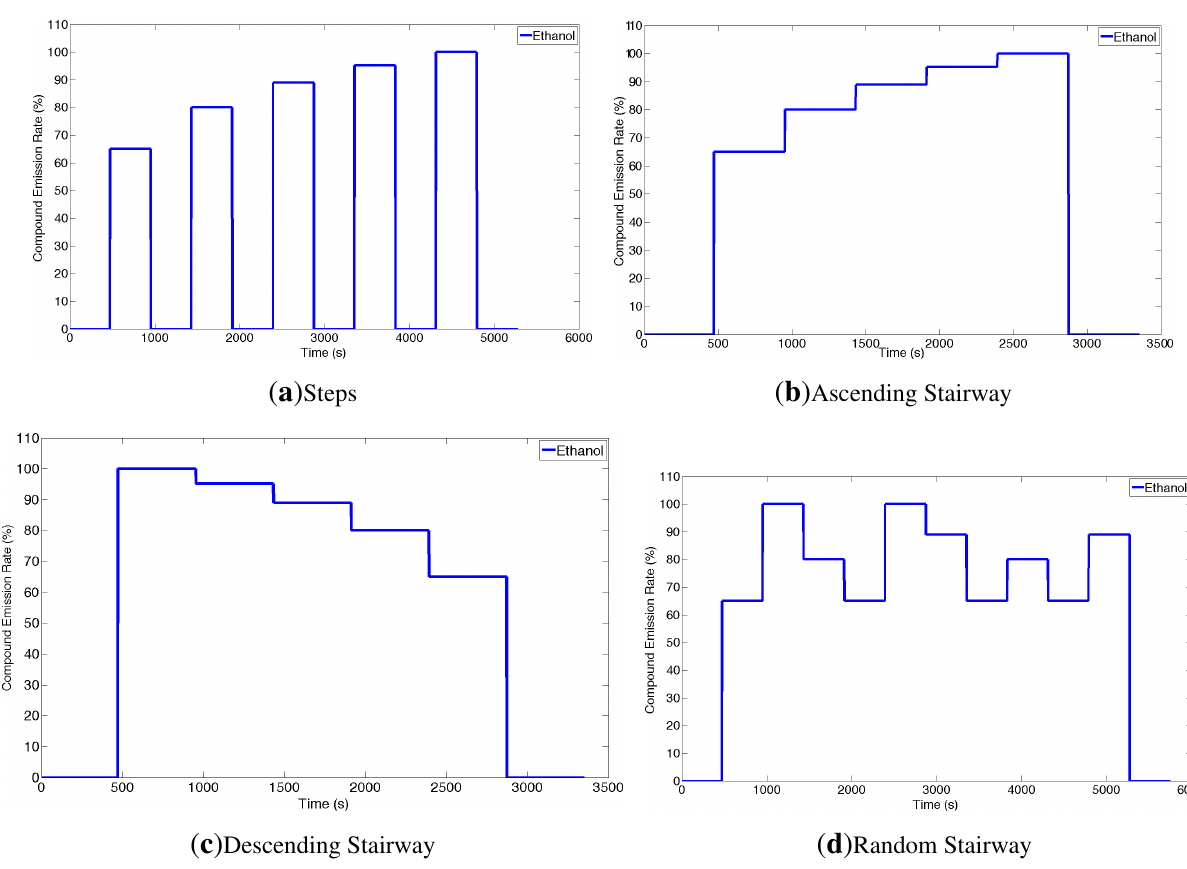
Figure 3. Gas source emission profiles. Profiles ( a – d ) are displayed. For the randomized profile ( d ), one exemplary instance is